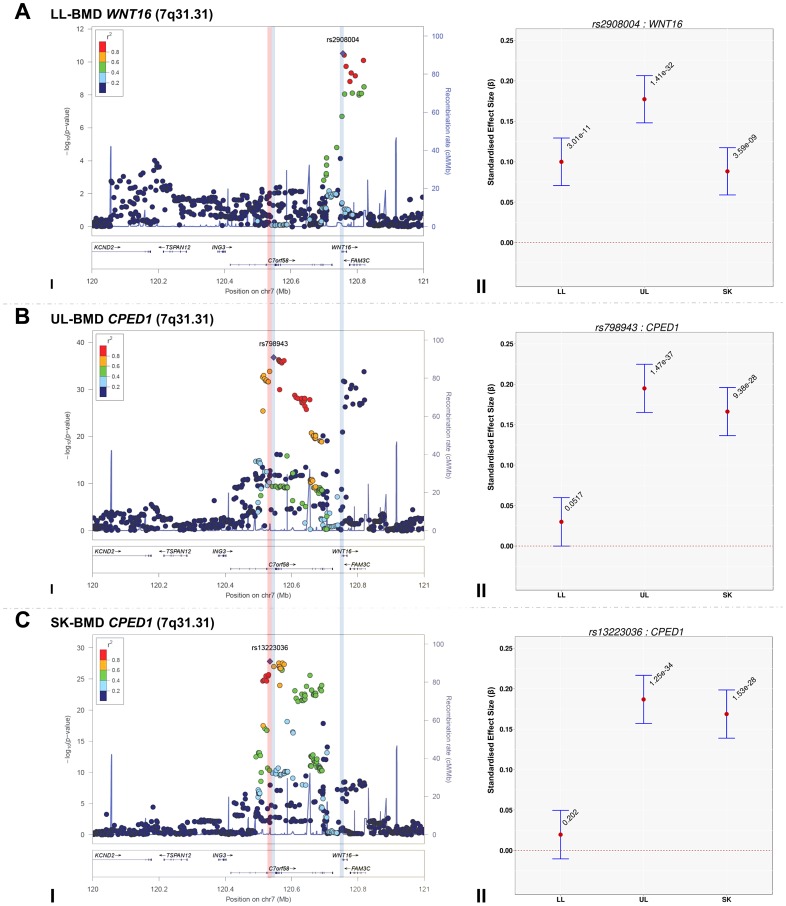
Regional association plots of the top SNPs associated with total-body less head-, lower limb-, upper limb- and skull-BMD at the 7q31.31 locus, in addition to a comparison of the effect size of the top site-specific SNP on BMD at the three different skeletal sites.For I: Circles show GWA meta-analysis P-values and positions of SNPs found within the 7q31.31 locus. Top SNPs are denoted by diamonds. Different colours indicate varying degrees of pair-wise linkage disequilibrium (HapMap 2 CEPH) between the top SNP and all other SNPs. Blue vertical shaded areas indicate the position of rs7776725 (top SNP A-I) and rs2908004 (top SNP B-I) and rs798943 (top SNP C-I) for each analysis. The red vertical shaded area represents the position of rs13223036 (top SNP D-I). For II: The per allele effect in SD (red dot) and the 95% confidence interval (error bar) of the top SNP for lower limb (LL), upper limb (UL) and skull (SK) are plotted with their specific strength of evidence against the null hypothesis of no association. Please note: FAM3C and CPED1 are also located at the 7q.31.31 locus containing WNT16.